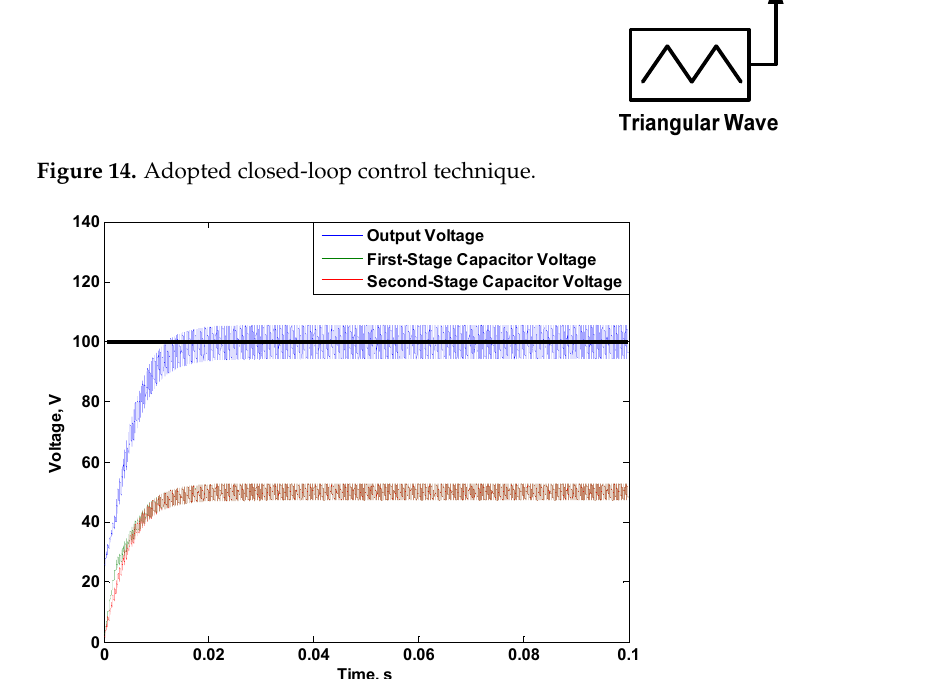
Figure 15. Output, first-stage capacitor and second-stage capacitor voltages at a reference voltage of 100 V.